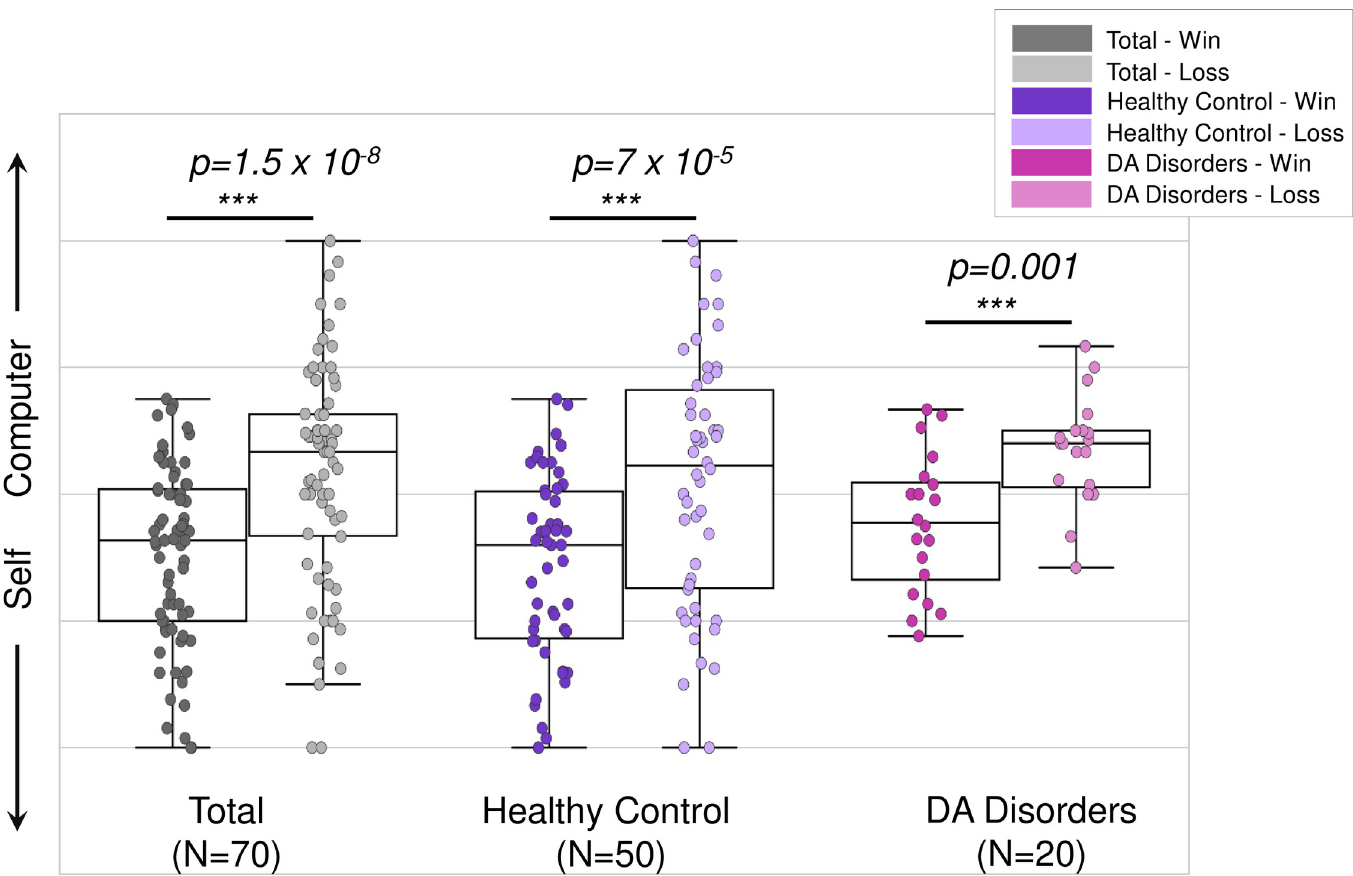
Fig 2. Higher positive feedback-related self-agency across all groups. Agency ratings plotted following positive-win (darker colors) and negative-loss (lighter colors) feedback during Ambiguous trials for all subjects (N = 70), healthy control subjects only (N = 50) and subjects with depression and anxiety (DA) disorders (N = 20). All subjects demonstrated higher self-agency following positive-win outcomes compared to negative-loss outcomes.